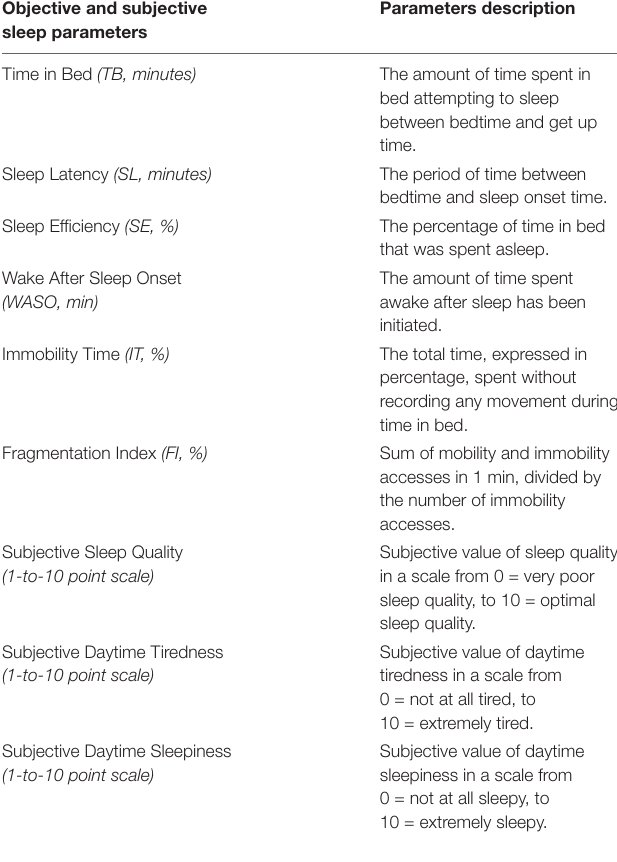
TABLE 1 | Description of the six sleep parameters evaluated through actigraphy and the three subjective parameters of sleep quality, daytime tiredness, and daytime sleepiness in soccer